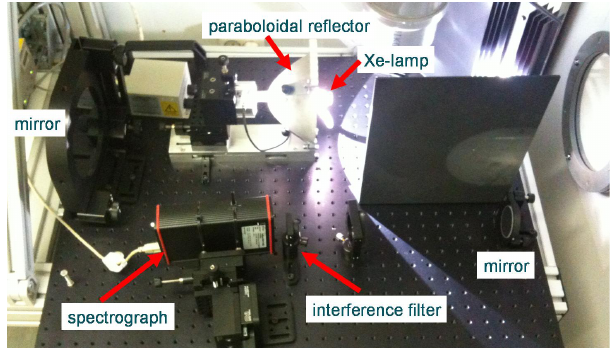
Fig.7. PhotographoftheminiDOASbreadboardinstrument. Fig. 7. Photograph of the miniDOAS breadboard